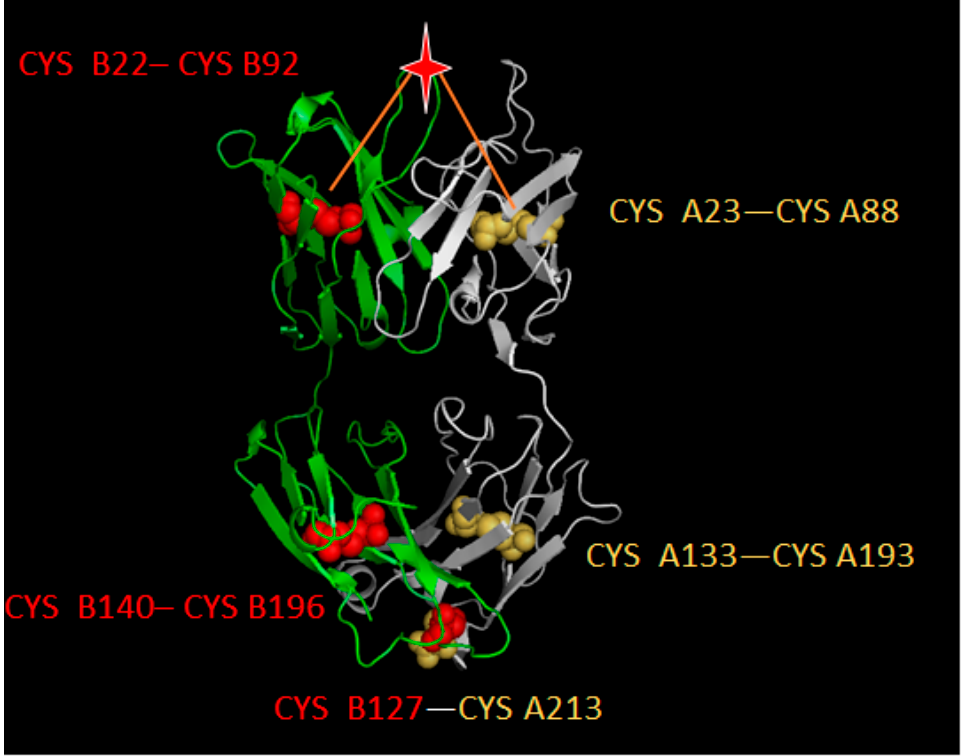
Figure 4. Disulfide bond illustration on the three-dimensional structure of an antibody (PDB id: 1AD9). The light chain (chain A) was marked in white while the heavy chain (chain B) was marked in green. Balls show the location of CYS and the star refers to the target residue to be described. Red balls represent CYS on heavy chain while yellow balls represent CYS on light chain. Red lines illustrate the Euclidean distance from benchmark points.